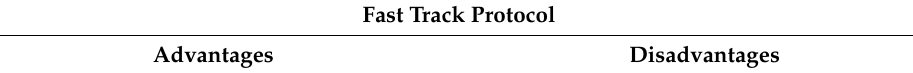
Table 5. Advantages and disadvantages of the Fast Track